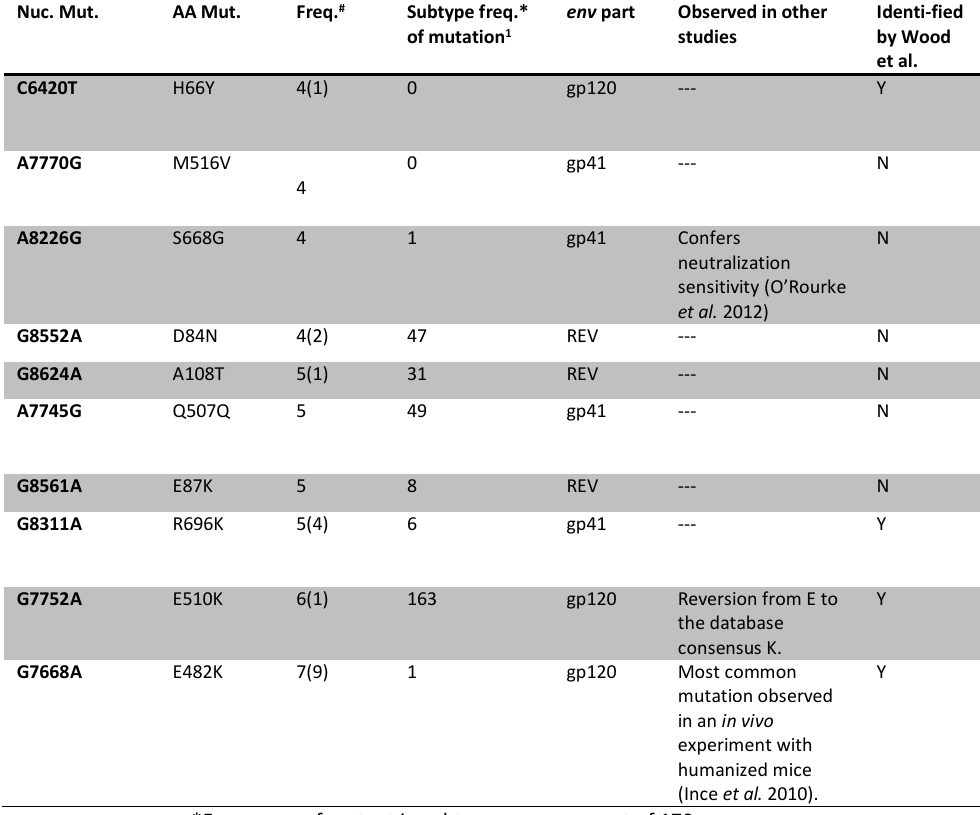
Table 1. Convergent mutations occurring in four or more HIV-1 populations in parallel. Nuc.